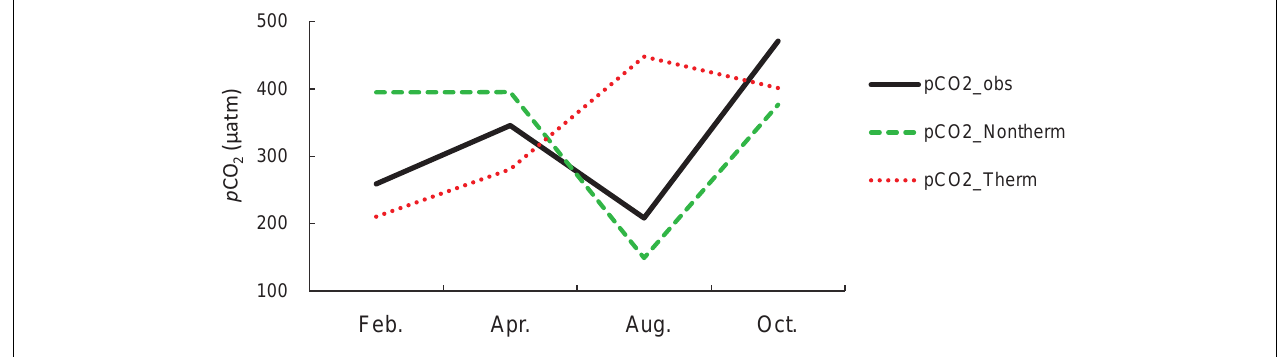
FIGURE 8 | Drivers of seasonal variability in p CO 2 for each observed month. In situ values are shown with a solid black line. Dotted red lines show the p CO 2 variations caused by seasonal variations in temperature, whereas dashed green lines show the p CO 2 variations caused by non-thermal contributions.